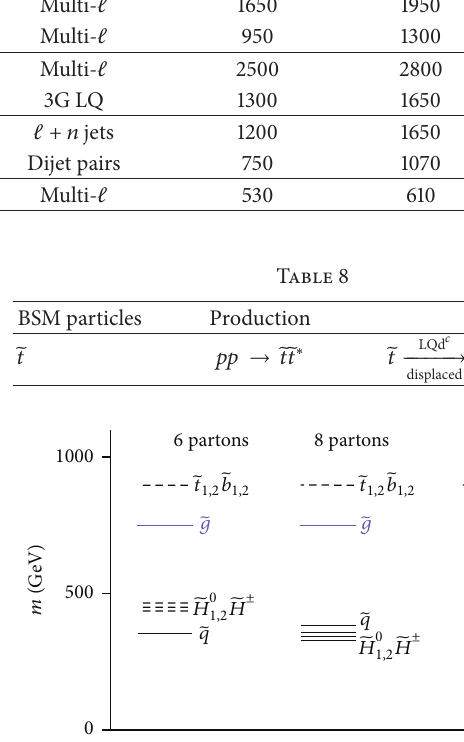
Figure 8: Possible RPV spectra that give rise to large jet multiplicity signals with little or no mET, leptons, or photons